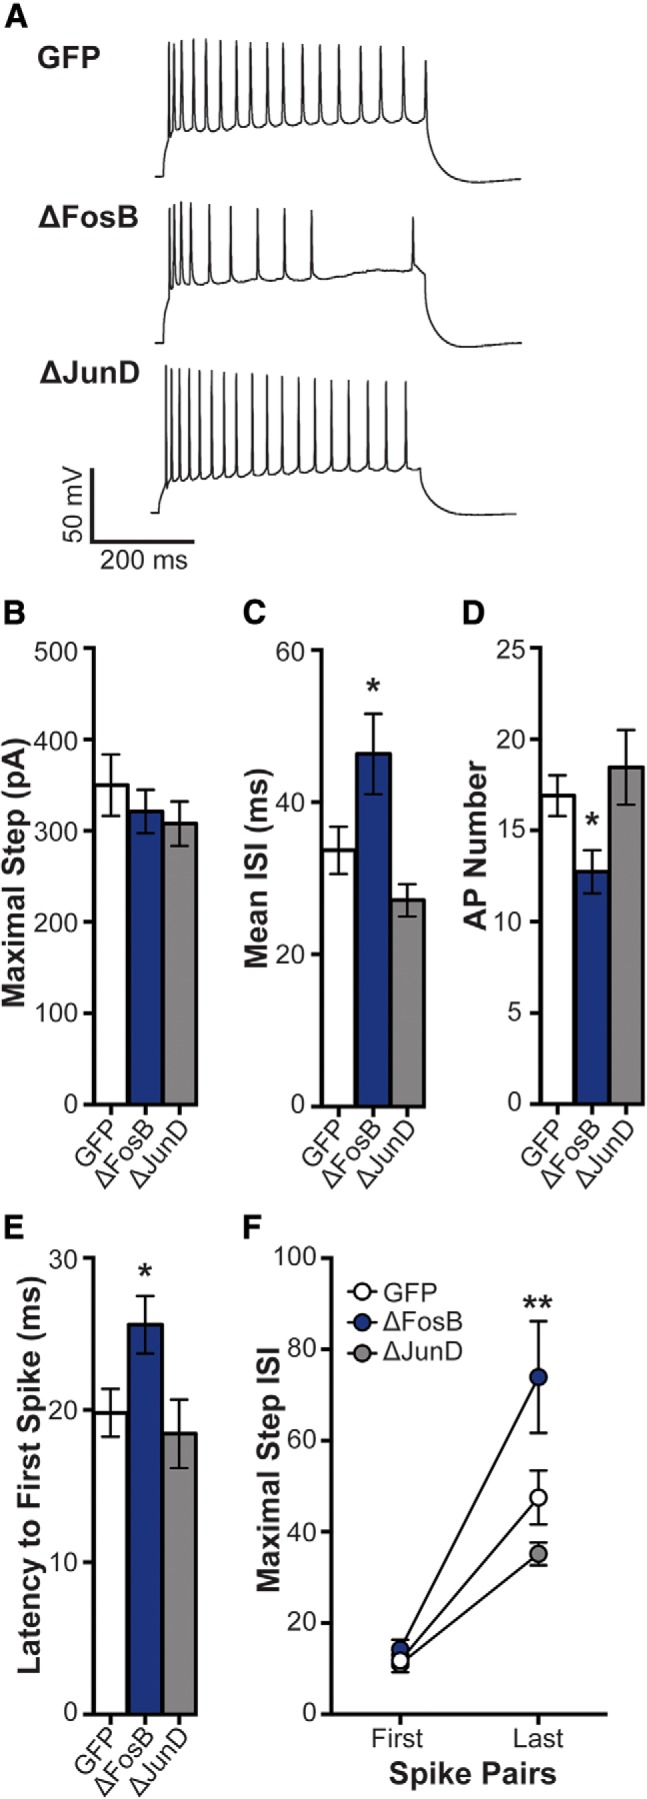
ΔFosB enhances spike frequency adaptation. A, Representative spikes at maximal depolarizing current injection in dHPC CA1 neurons transduced by HSV-GFP (GFP), HSV-GFP + ΔFosB (ΔFosB), and HSV-GFP + ΔJunD (ΔJunD). B, The maximal depolarizing current was used to assess spike frequency adaptation among GFP (n = 21 cells; n = 8 mice), ΔFosB (n = 19 cells; n = 9 mice), and ΔJunD (n = 14 cells; n = 5 mice). No differences were observed in maximal current; p > 0.05 (one-way ANOVA). C, Mean ISI (in ms) at the maximal step across groups. Mean ISI was increased by ΔFosB; *p < 0.05 compared with GFP (one-way ANOVA; Holm–Sidak comparisons). D, Number of APs at the maximal step across groups. ΔFosB significantly decreased the number APs; *p < 0.05 compared with GFP (one-way ANOVA; Holm–Sidak comparisons). E, Latency from the onset of the maximal step and the first spike was assessed for each group. ΔFosB increased the latency compared with GFP; *p < 0.05 (one-way ANOVA; Holm–Sidak comparisons). F, ISI for the first and last pair of spikes at the maximal step for each group. ISI at the last pair of spikes was increased by ΔFosB compared with GFP; **p < 0.01 (two-way repeated-measures ANOVA; Holm–Sidak comparisons). All graphs display means ± SEM.